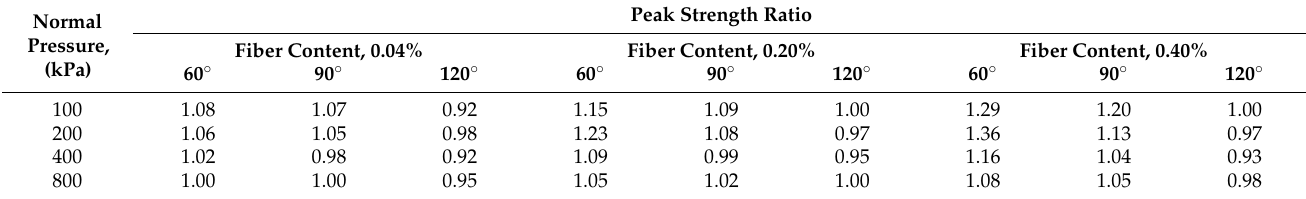
Table 2. Peak strength ratio of reinforced sand obtained from direct shear